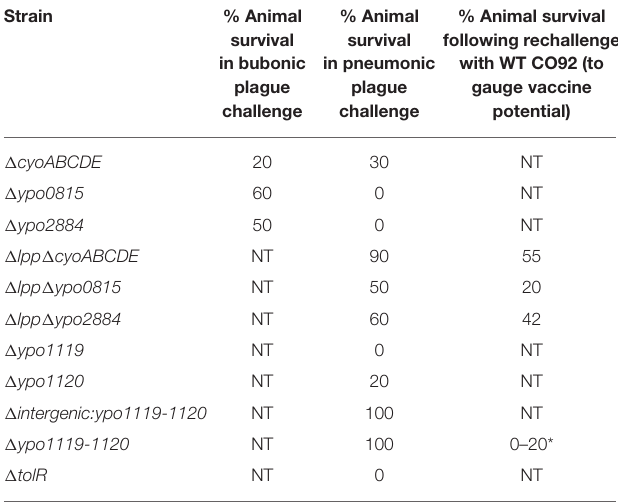
TABLE 2 | Summary of results for non-T6SS associated mutants in